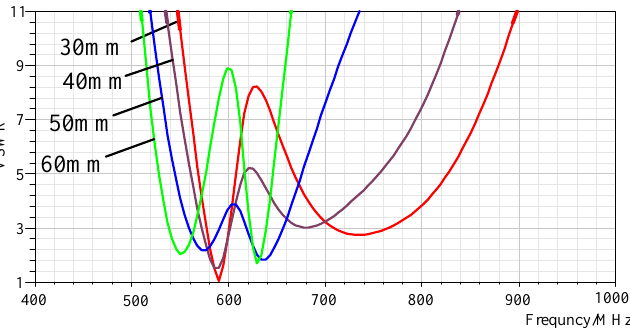
Figure 3. The VSWR curve of antennas with different feed point positions.